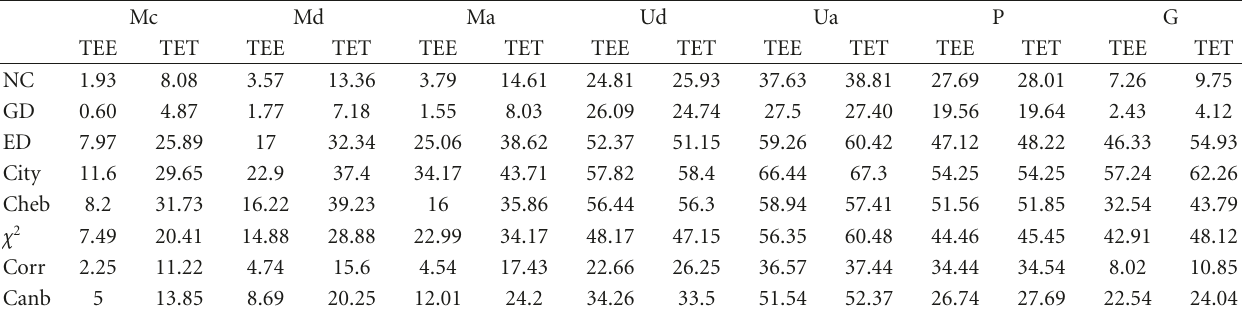
Table 3: ID verification results using di ff erent similarity measures for the manual registered data in the LDA feature space.